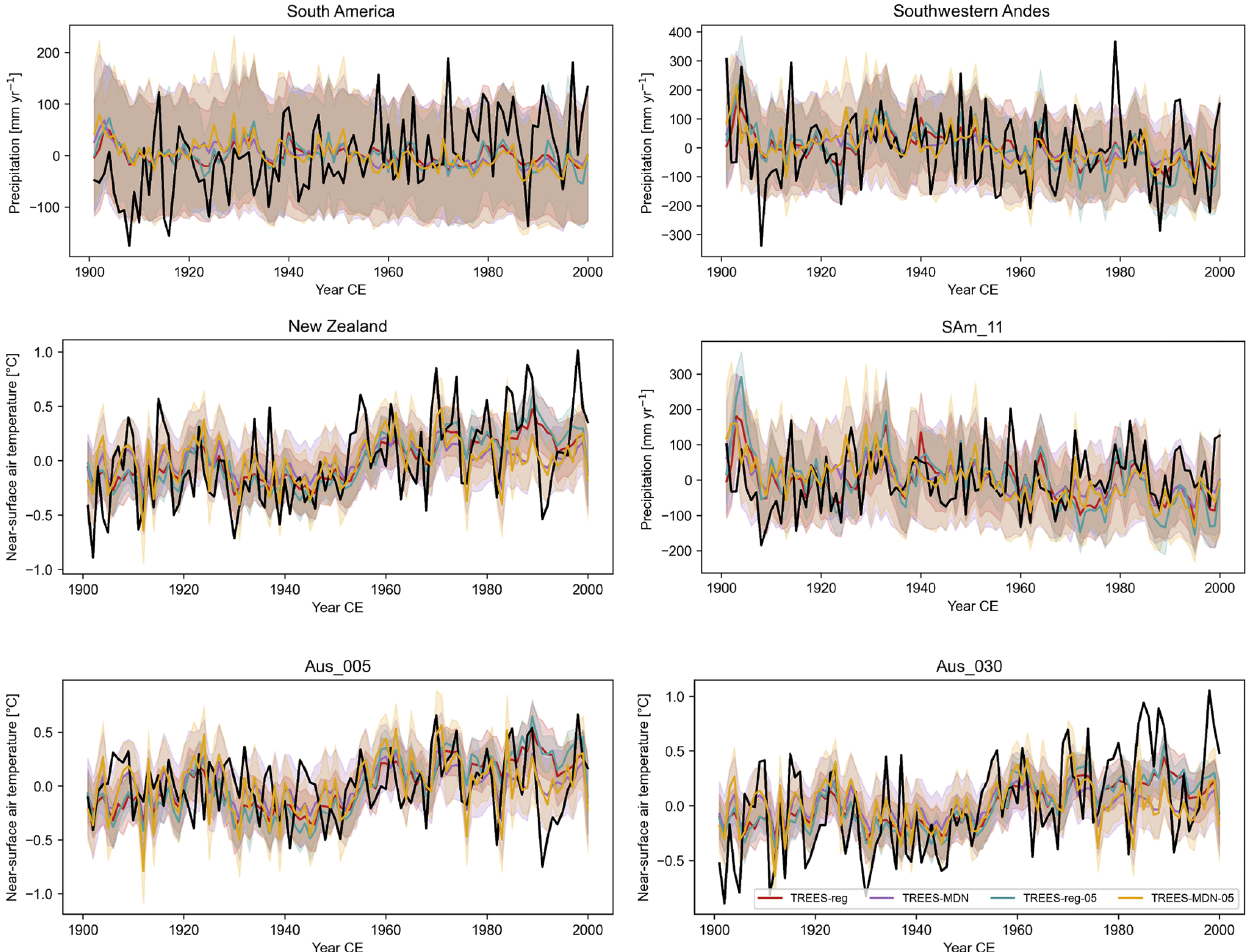
Figure 7. Reconstructed (in color) and GMF (in black) temperature (in ◦ C; relative to 1901–2000CE) or precipitation anomalies (in mmyr − 1 ; relative to 1901–2000CE) over 1901–2000CE for different DA experiments (Table 1, with tree-ring proxies only, with the full observation error or half of the observation error; see Sect. 3 for more details) in different regions (Sect. 3) and proxy sites (Fig. 1). Aus refers to a site in New Zealand and SAm in South America. The uncertainty (i.e., the ensemble spread; Sect. 2.1) associated with each reconstruction is represented by the shaded